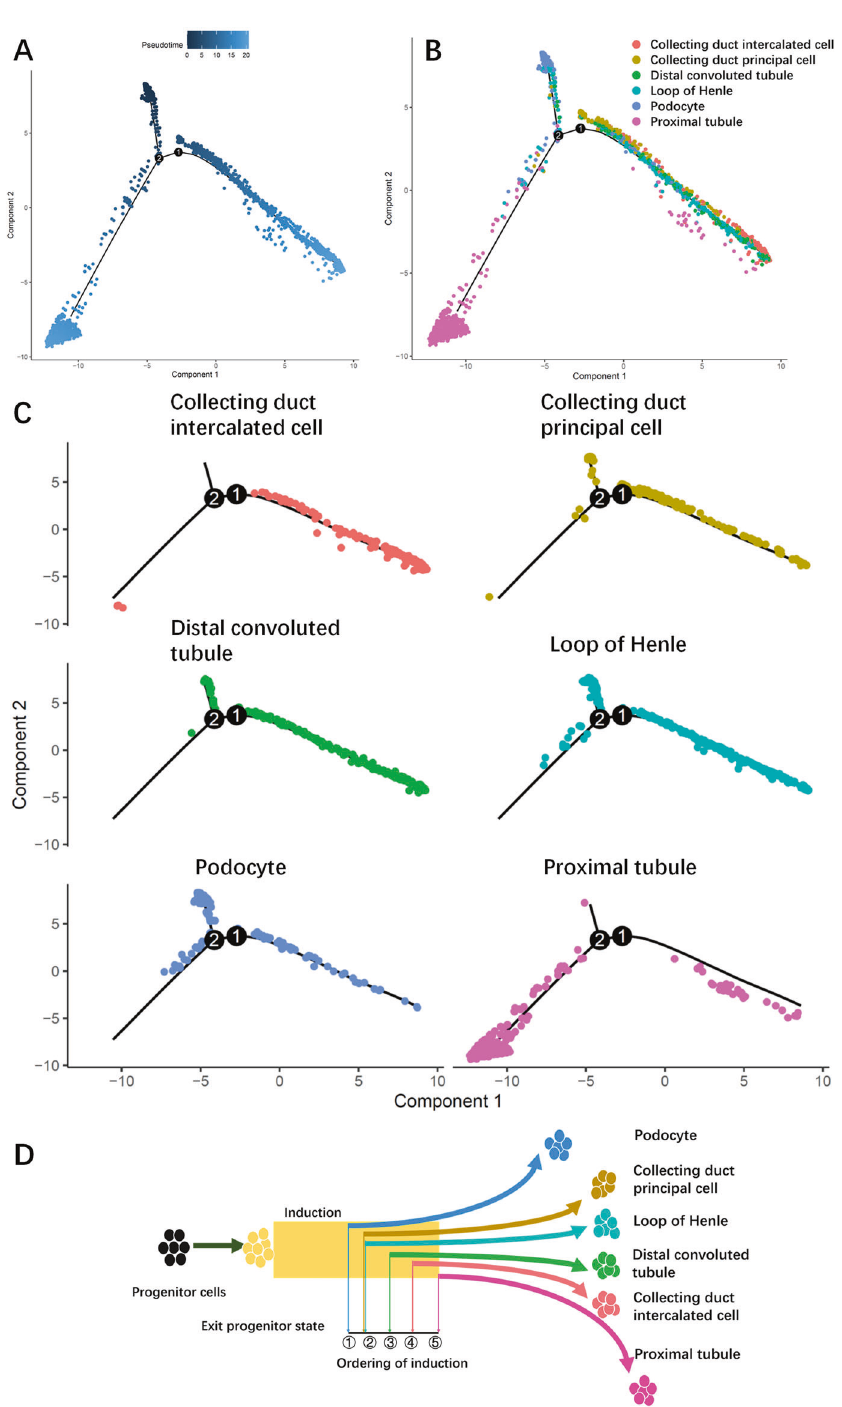
Fig. 3 Distinct phases of major kidney cell clusters during the development of postnatal rat kidney. A , B Pseudotime trajectory of the major kidney cells (collecting duct intercalated cells, collecting duct principal cells, distal convoluted tubules, loop of Henle, podocytes, and proximal tubules). Cells are colored based on the predicted pseudotime. The deeper the color, the earlier it is ( A ). Cell type transition during the development of rat kidney after birth according to pseudotime path ( B ). C Split monocle pseudotime plot revealed detailed development of the major kidney cell clusters. D Overview of different cell cluster fates along cumulative time as indicated by pseudotime. Numbers 1 – 5 present the ordering of cell type induction based on pseudotime. Podocytes were the fi rst cell type to be induced from the progenitors and to reach their mature fate, followed by the loop of Henle and collecting duct principal cells, and then distal convoluted tubules and collecting duct intercalated cells, with proximal tubules being the fi nal mature cell type observed kidney con fi rmed the possible key role during mid and late kidney development. Thus, negative factors occurring during the mid and late stages of kidney development may also cause an adverse effect on the LOH. The LOH plays a role in successful radiation, and short